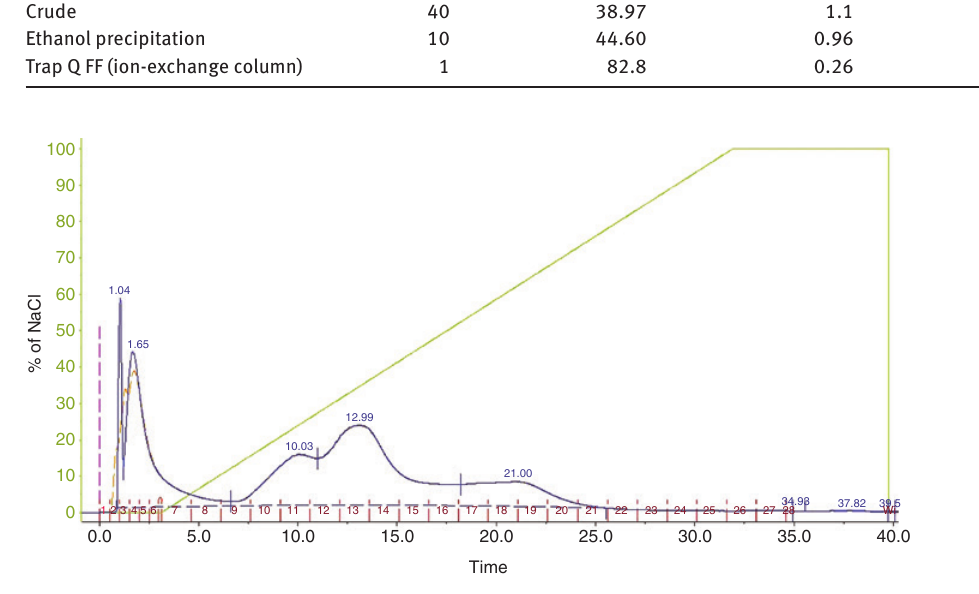
Figure 1: Ion exchange chromatogram of purified pterin